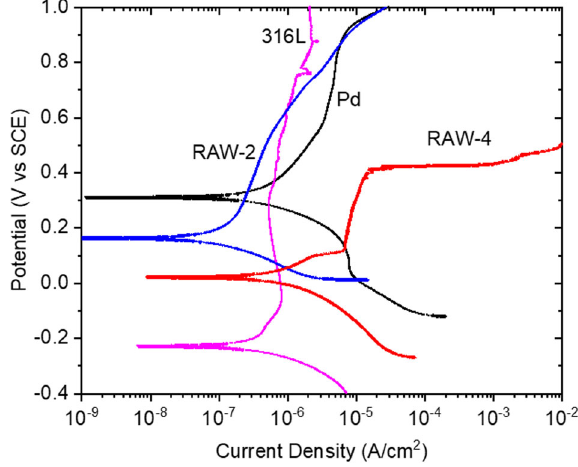
Fig. 3 PD scans in air saturated acidic NaCl solution at room temperature. Showing results for RAW-2, RAW-4, 316L SS, and Pd